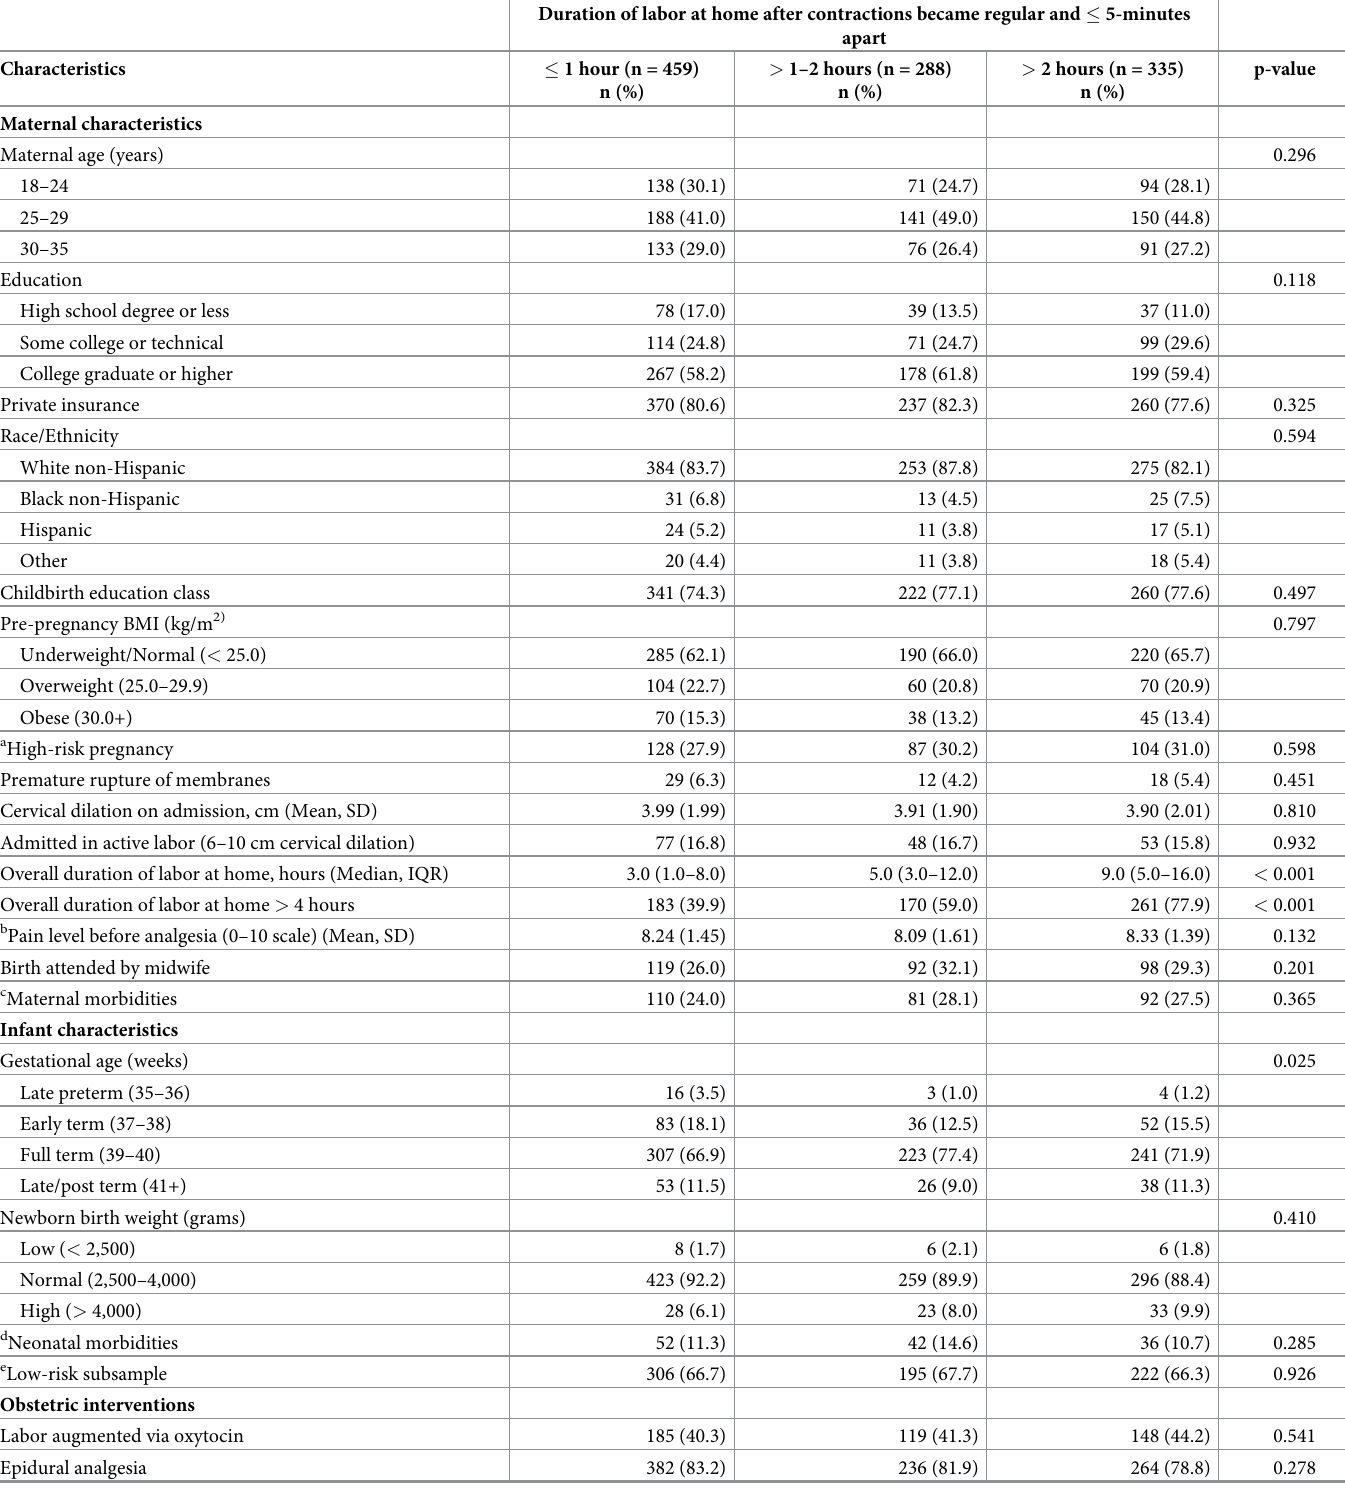
Table 3. Maternal and infant characteristics by duration of labor at home after contractions had become regular and � 5-minutes apart (n = 1,082).